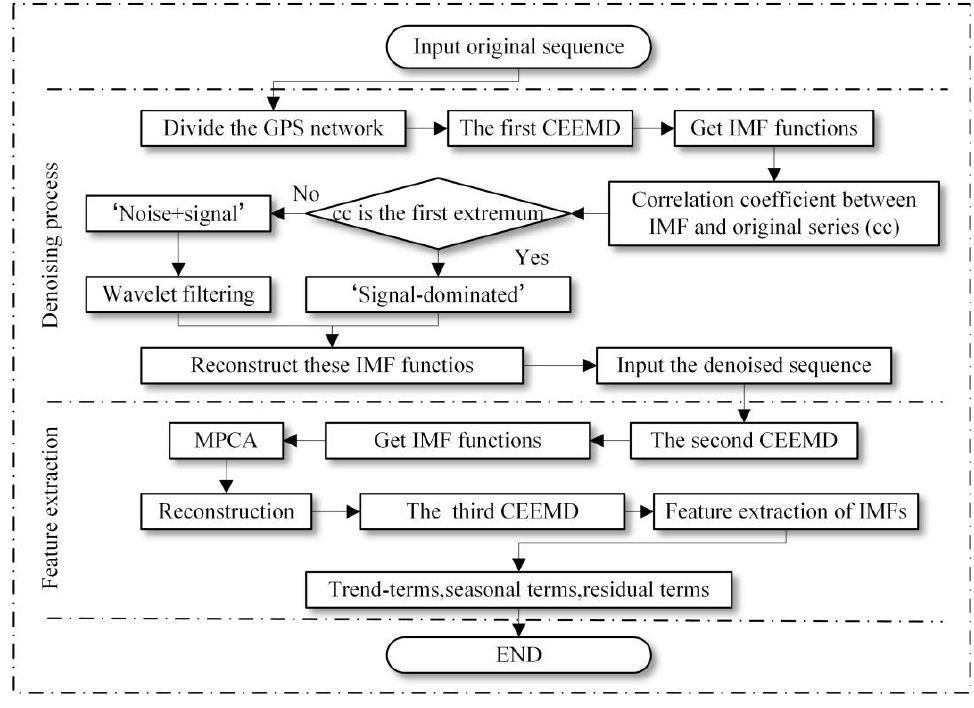
Figure 3. Flowchart of the proposed method.